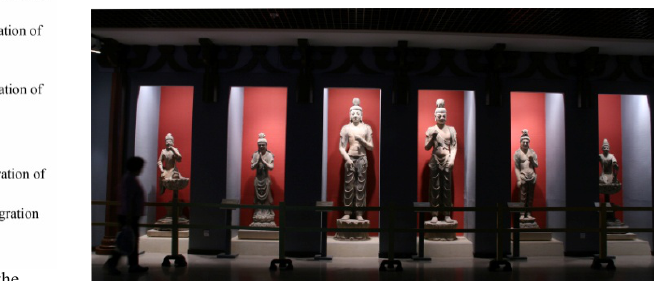
Fig.5 Migration of the tower after the earthquake